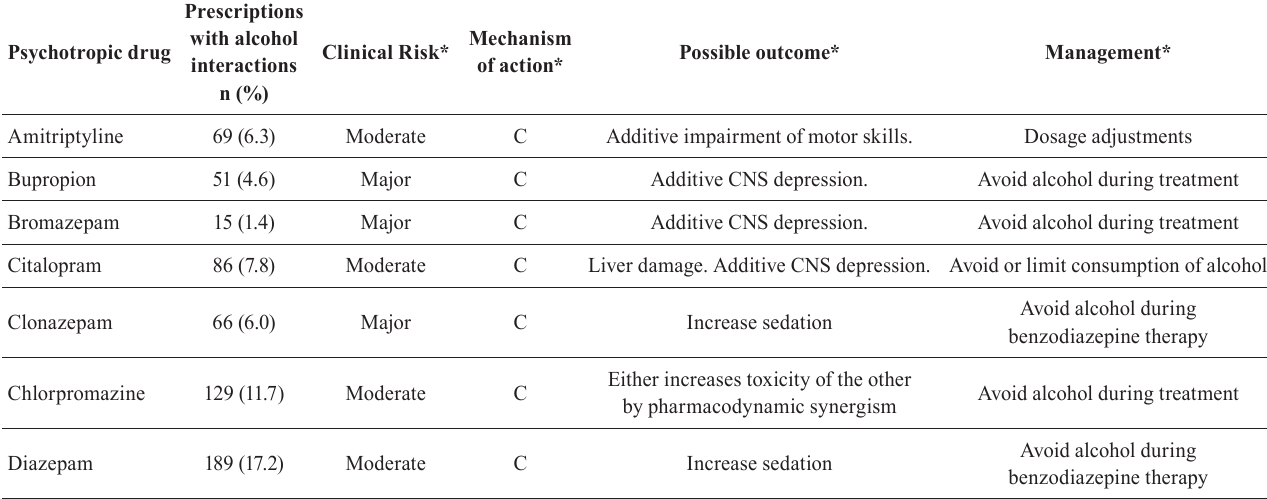
TABLE II - Frequency of prescriptions with drug interactions between psychotropics drugs and alcohol and tobacco